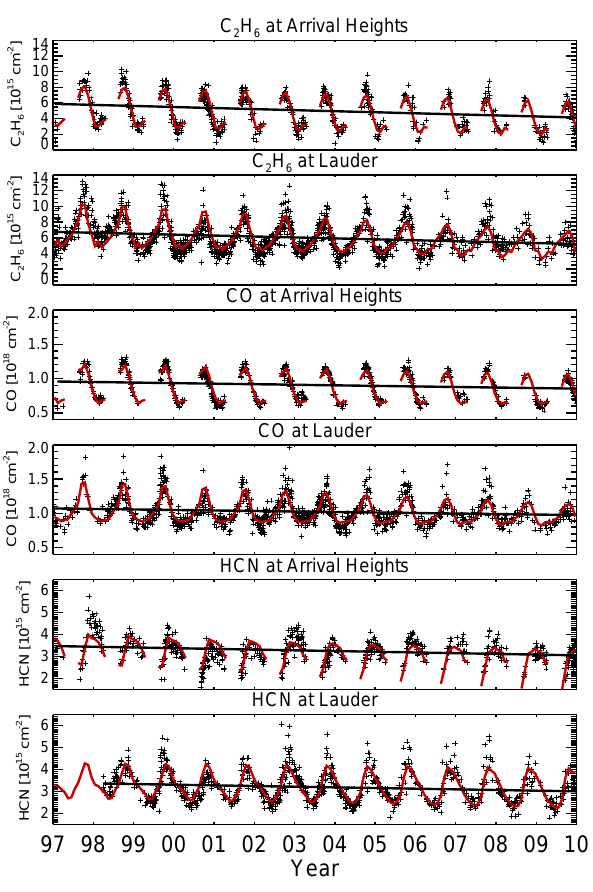
Fig. 1. Time series of CO, C 2 H 6 , and HCN partial columns (moleculescm − 2 ) recorded at Lauder and Arrival Heights (black symbols), month-by-month linear regression (red line) and the multi-annual linear trends (black line).